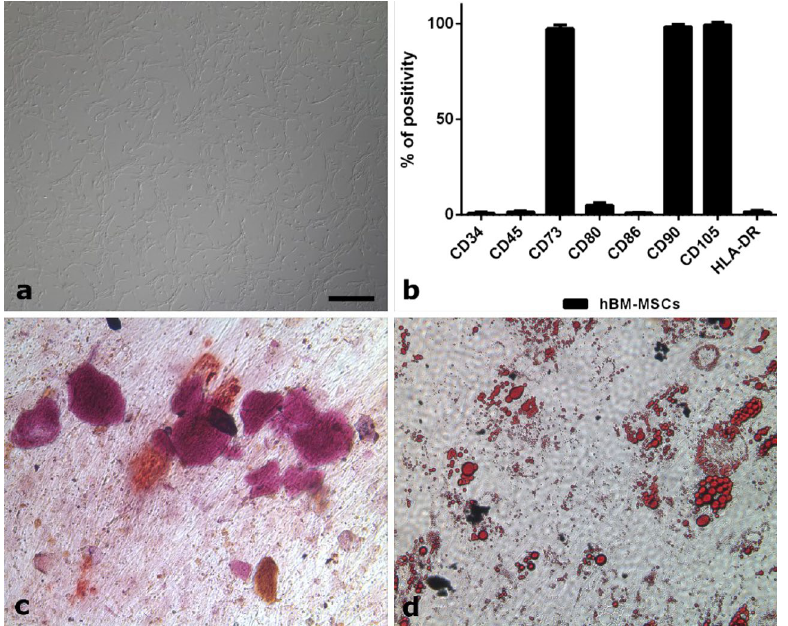
Figure 4. ( a – d ) MSCs characterization after in vitro expansion. ( a ) Cells, isolated from the bone marrow of a healthy donor, display the typical spindle-shaped morphology of MSCs. ( b ) Immunophenotyping by flow cytometry reveals expression of MSCs markers (CD73, CD90, and CD105) and lack of hematopoietic markers (CD34, CD45, CD80, CD86, and HLA-DR). ( c ) After incubation with the appropriate medium, the isolated cells were able to differentiate into osteoblasts as revealed by Alizarin Red staining (Sigma-Aldrich), which highlights calcium depositions. ( d ) At the same time, the isolated cells were also able to differentiate into adipocytes, as detected by Oil Red O (Sigma-Aldrich), which makes fat droplets visible. All the figures in the panel are the same scale; bar—200